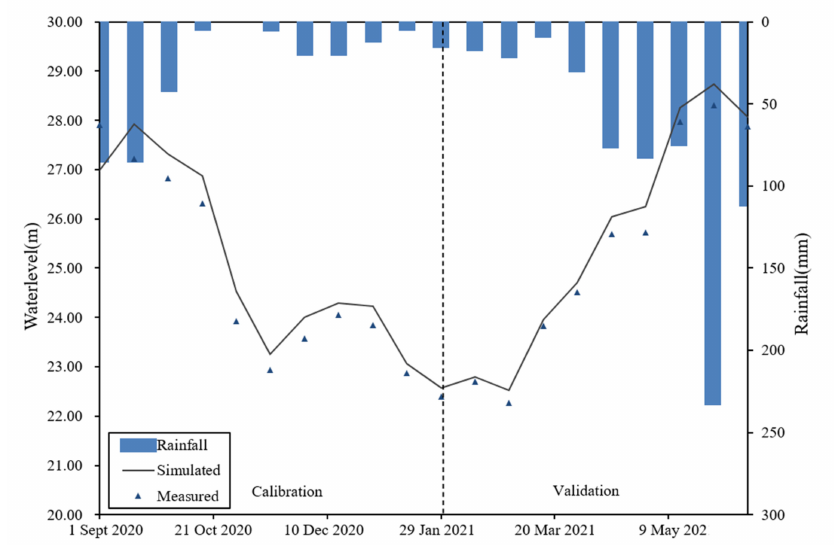
Figure 5. Measured and simulated water level values in the Yujiang River